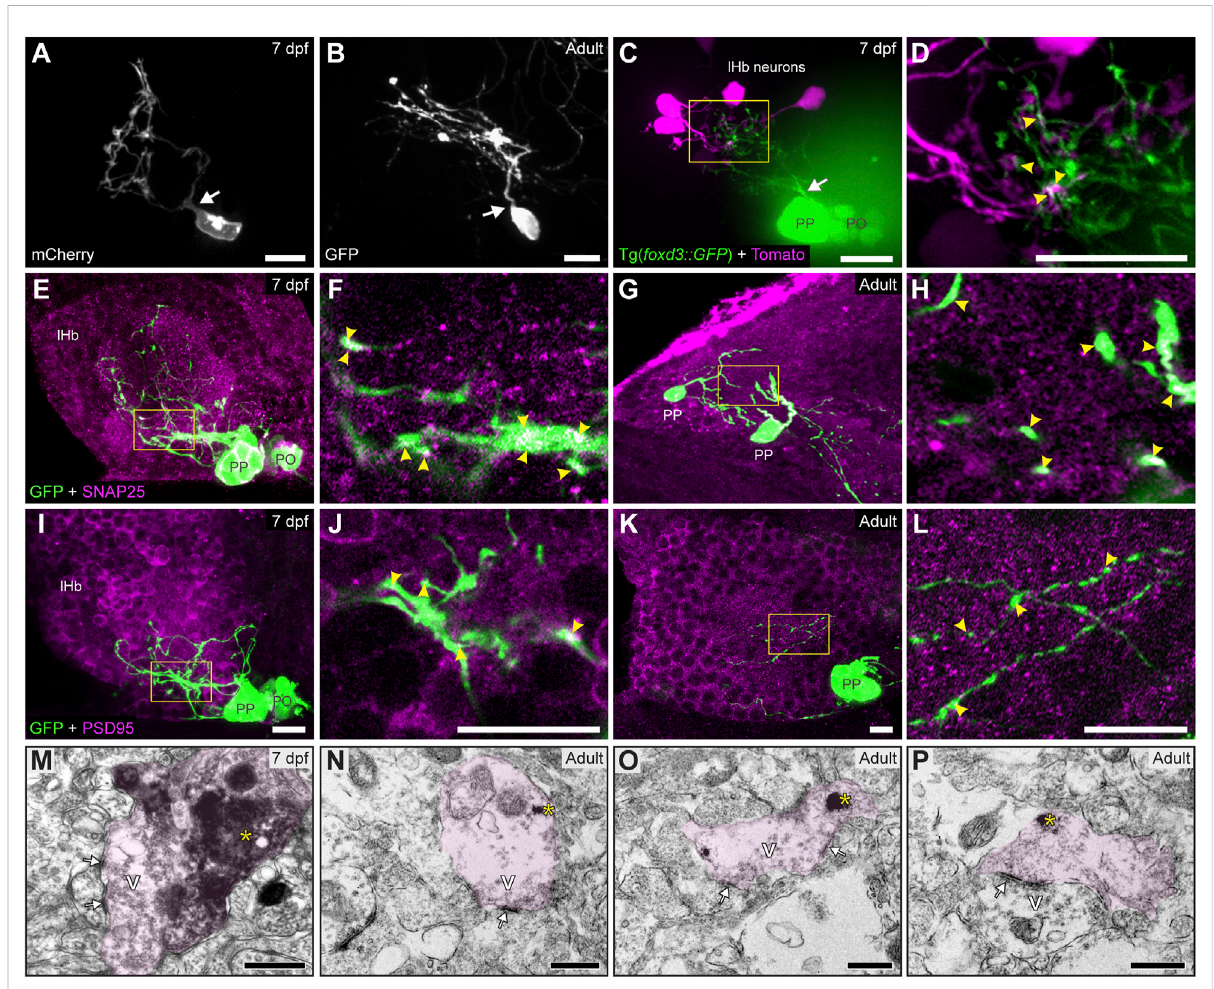
FIGURE 2 Contacts and synapses between parapineal cells and the left habenular neuropil in the larva and adult zebra fi sh. (A,B) Dorsal views of confocal z-stack maximum projections showing single parapineal cells expressing mCherry in a living larva at 7 dpf (A) and GFP in a section of the 1.5 – 2 years old adult brain (B) after immunostaining against this fl uorescent protein. At both stages, parapineal cells show a characteristic pear-shape cell body with a single projection emerging from it (white arrows) and then branching profusely. (C,D) Dorsal views of confocal z-stack maximum projections showing4habenularneuronsexpressingthe fl uorescentproteinTomato(magenta)inaliving7 dpfTg( foxd3::GFP )larva expressing GFP inthepinealcomplex(green).Projectionsemergefromtheparapinealbodyasabundle(whitearrow),thenbranchinthelefthabenulatointermingle with the dendritic arbour of the labelled habenular neurons. The image in (D) corresponds to a z-plane of the yellow rectangle depicted in (C) , showing the punctuated zones where the fl uorescent signals corresponding to parapineal projections (green) closely associate with the fl uorescencesignalscorrespondingtohabenulardendrites(magenta). (E – L) Dorsalviewsofimmuno fl uorescenceagainstpresynaptic(SNAP25)and postsynaptic (PSD95) markers in the epithalamus of larval (7 dpf) and adult (1.5 – 2 years old) zebra fi sh. Images correspond either confocal z-stack maximum projections (E,G,I,K) or to single z-planes ( F,H,J,L ; corresponding to the yellow rectangles depicted in E,G,I,K , respectively) of larval (E,F,I,J) and adult (G,H,K,L) animals. Yellow arrowheads point to zones where the fl uorescent signal from to parapineal projections (green) closely associate with the immuno fl uorescence signal of the synaptic protein (magenta). (M – P) TEM images showing the synaptic relation between parapinal cells and the habenular neuropil at larval (7 dpf) (M) and adult (1.5 – 2 years old) (N – P) stages. GFP-immunopositive terminals of parapineal projections showing black DAB precipitates (yellow asterisks) are shaded in pink. These terminals show synaptic vesicles (v) and synaptic densities (white arrows) both in larvae and adults. Abbreviations: lHb (left habenula), PO (pineal organ at the level of the stalk), PP (parapineal). Scales bars, 10 µm (A – L) , 500 nm (M – P)